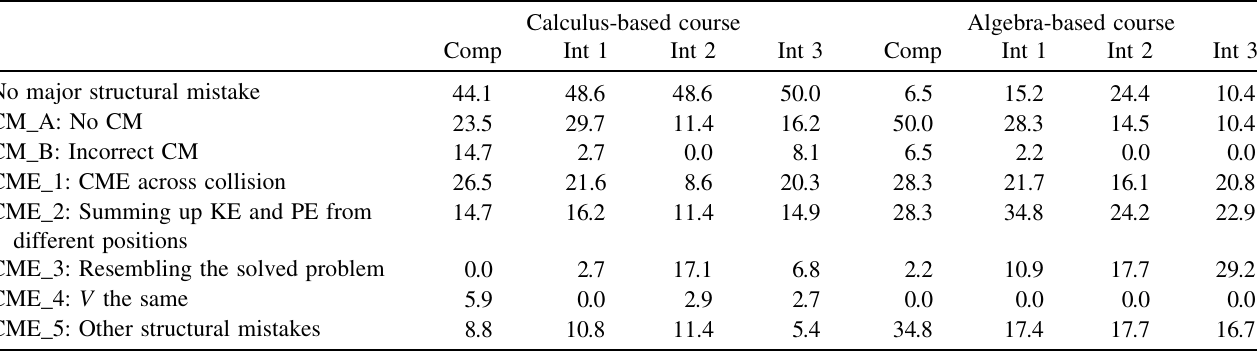
TABLE XII. Students’ average scores out of 10 on the quiz (transfer) problem in the calculus-based course. Note that a single student may make both a mistake related to the CM principle and a mistake related to the CME principle. [For example, a student who ¼ ð m þ m Þ gh gh would be categorized as having made two mistakes: ‘‘CM_A: No CM’’ and ‘‘CME_1: CME had a solution m A o A B f across collision’’.] Therefore, the numbers in each column would sum up to 100% only if neither category A nor category B is counted for a